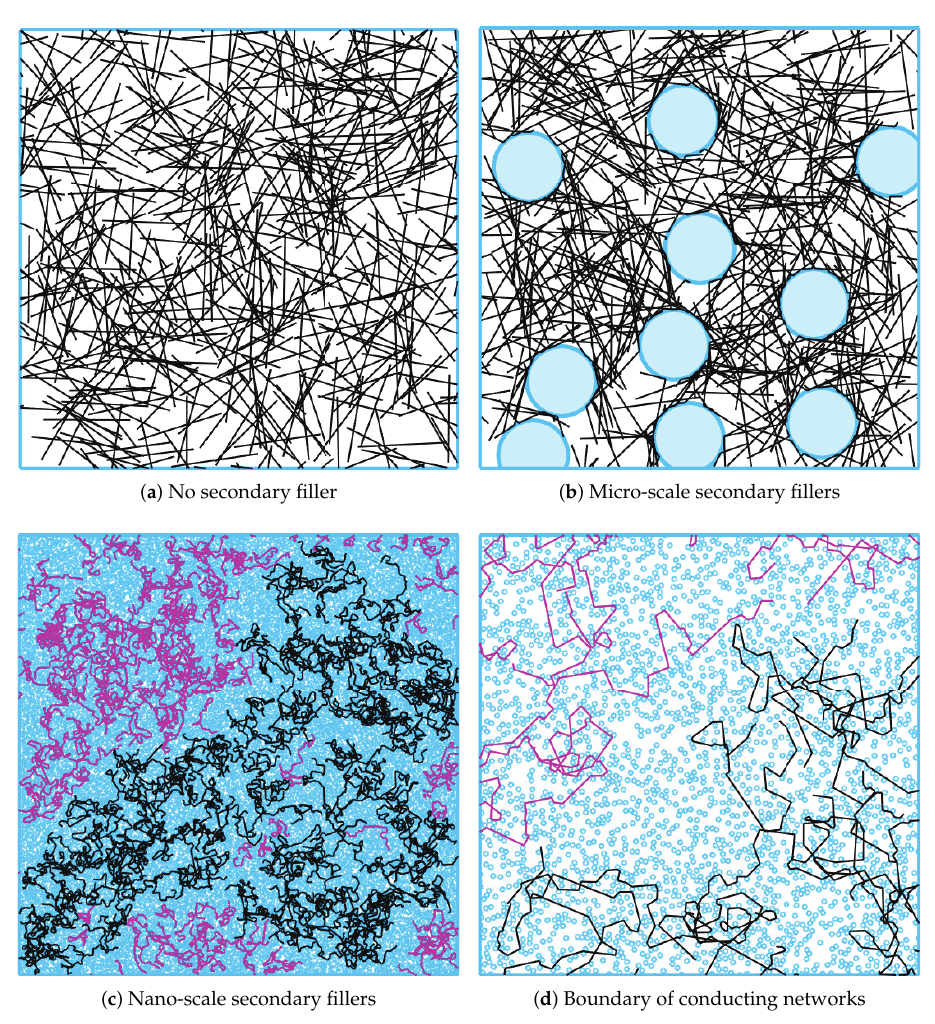
Figure 2. Random percolating networks for various